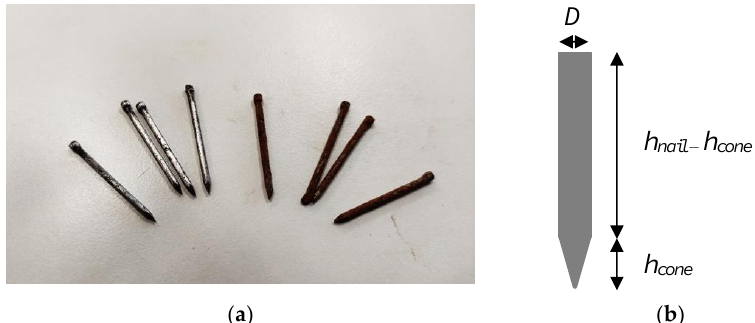
Figure 1. ( a ) Nails before and after rusting treatment; ( b ) Considered nail geometry.